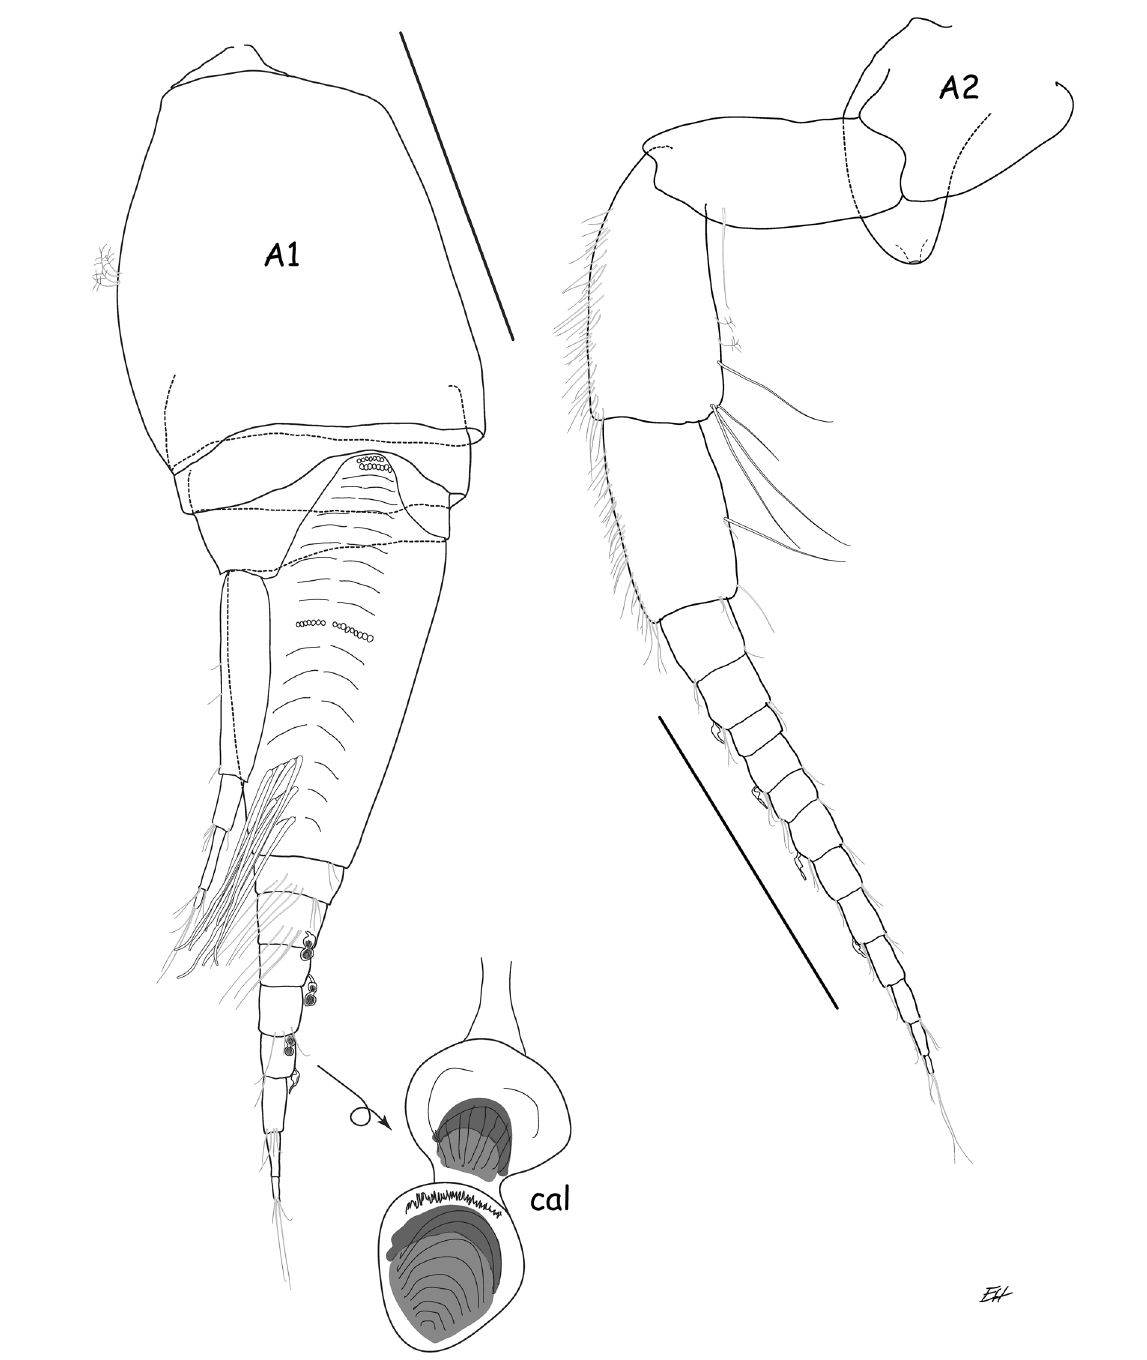
Fig. 27. Abyssorchomene shannonae sp. nov., allotype, ♂, 7 mm (ZMH K-61210). Most aesthetascs omitted from A1 callynophore. Scale bars = 0.5